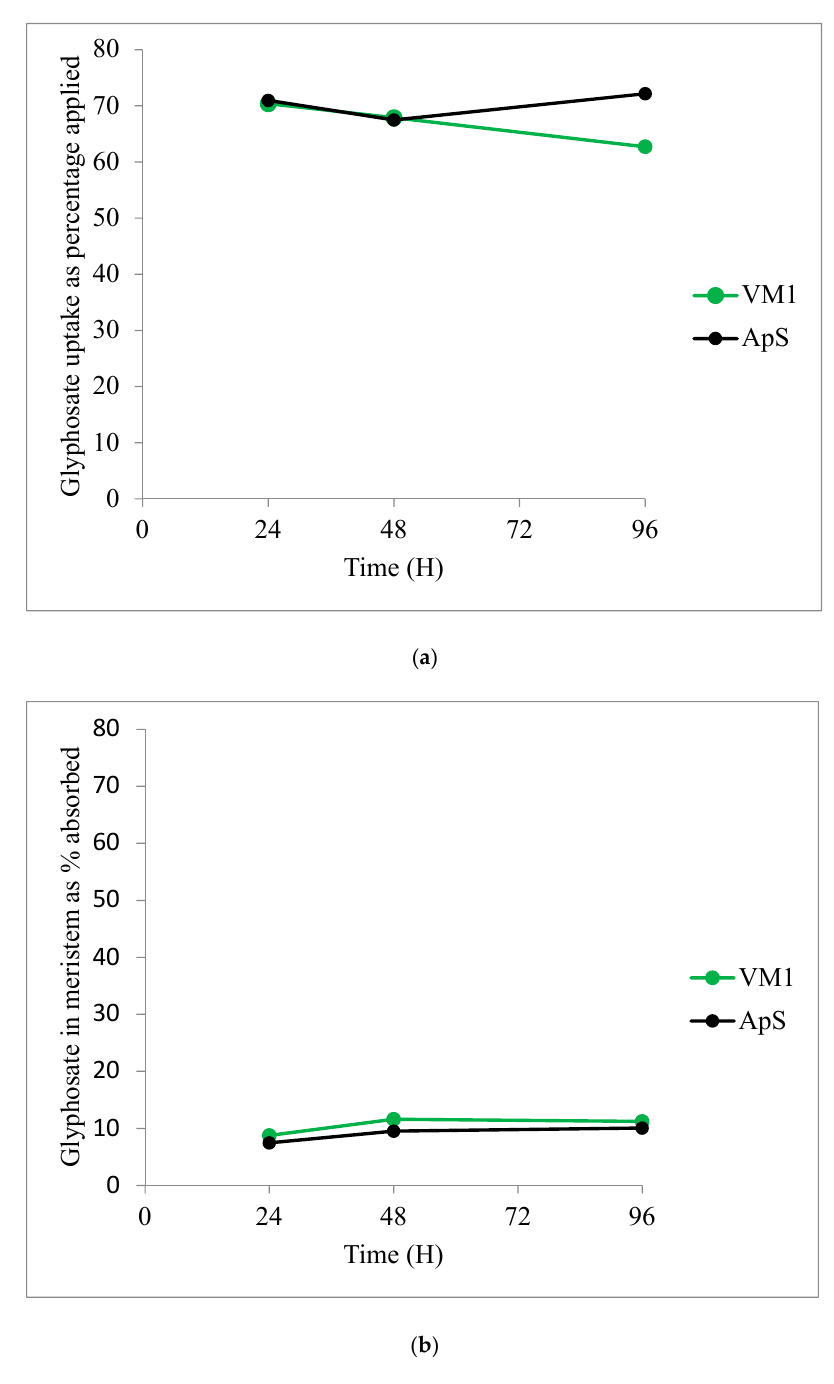
Figure 4. Relative uptake ( a ) of glyphosate and translocation to the meristem ( b ) in the standard sensitive ApS and VM1 A. palmeri populations.